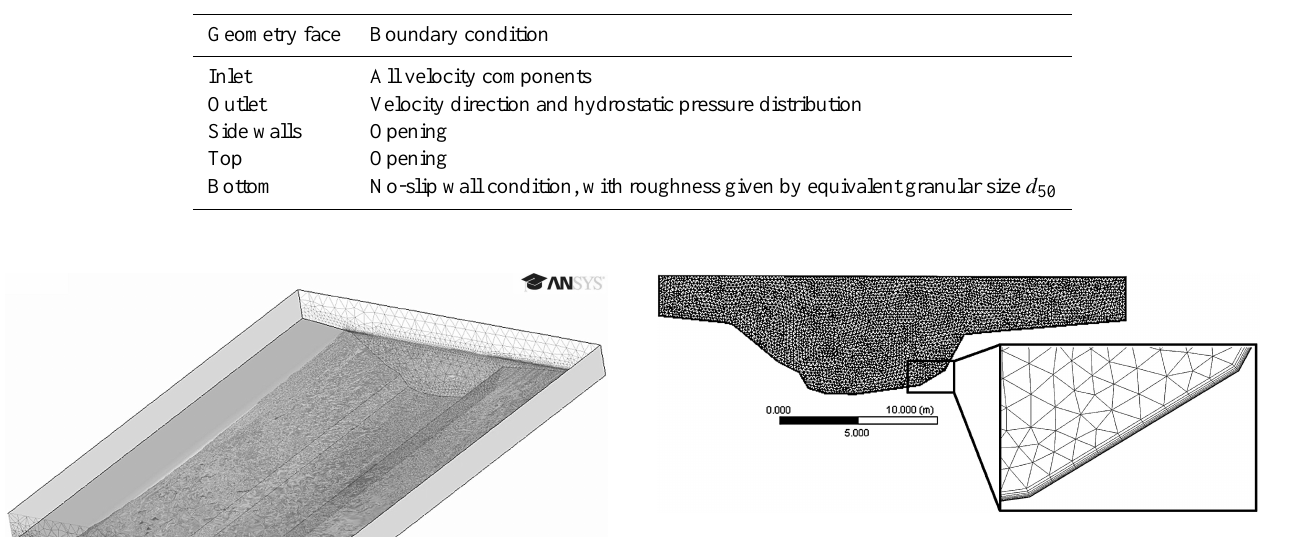
Table 7. Boundary conditions assigned in the CFX simulation.